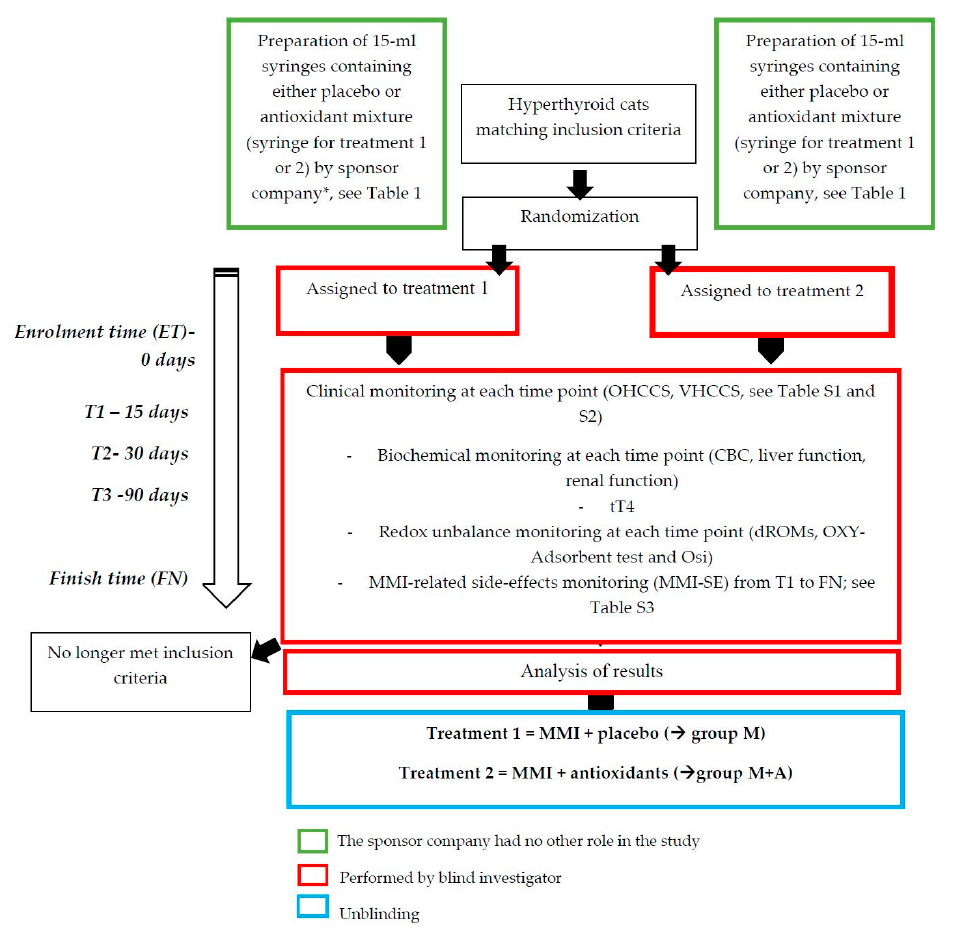
Figure 1. Schematic representation of the study design.